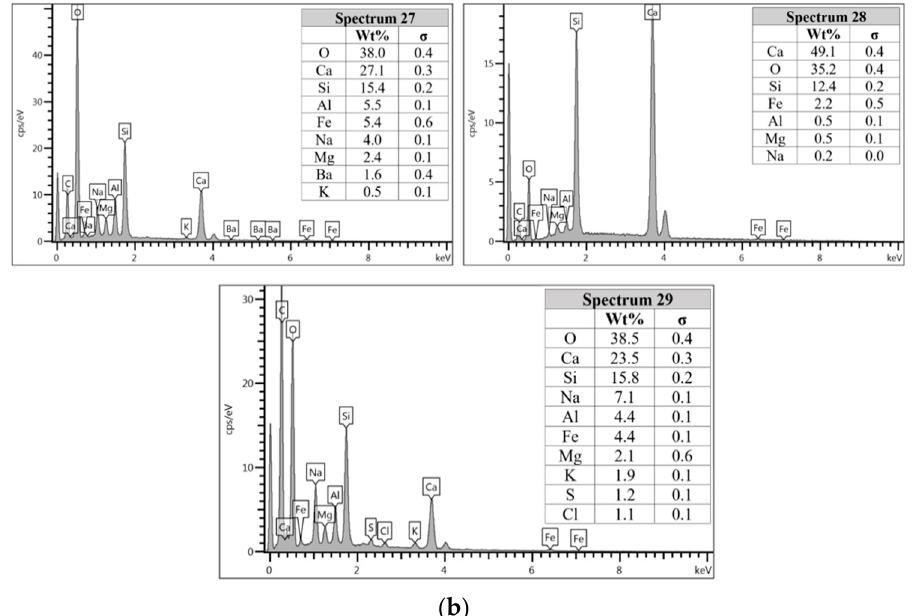
Figure 8. ( a ) Morphology of AAFA specimens cast in river water. ( b ) EDS for AAFA cast in river water.